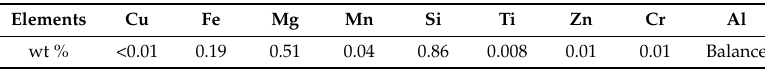
Table 1. Chemical composition of tested AA6063 in wt %.